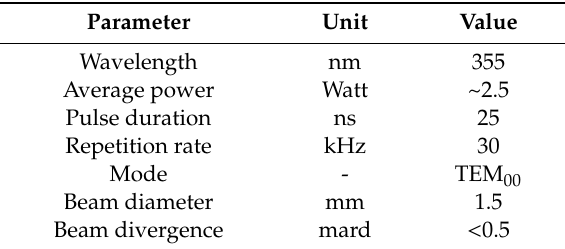
Table 1. Specifications of the 355 nm UV pulsed laser.